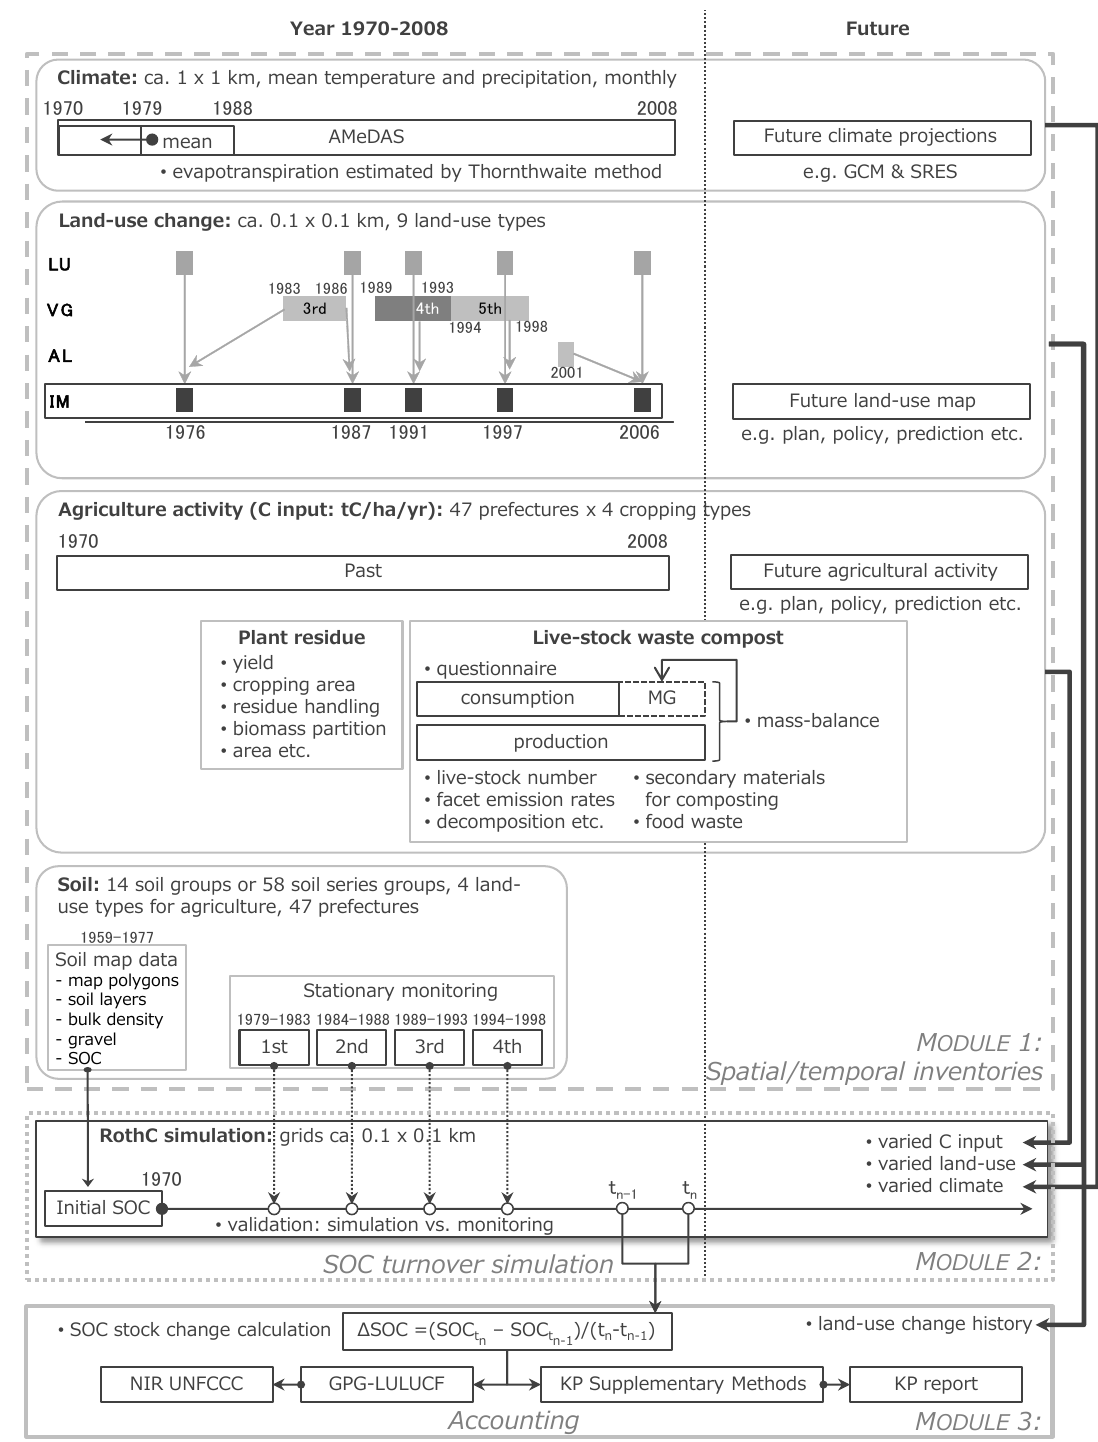
Figure 1. Schematic diagram of the system developed to simulate soil carbon stock change at country-scale using spatially explicit inventories on land-use change, climate, soil, and agricultural activity. The system is designed to be capable to simulate both historical and future soil organic carbon stock change, provided that spatial and temporal inventories are continuous or have appropriate time interval. See the text and Supplement for detail descriptions on other abbreviated text in figures; SOC: soil organic carbon: LU – land-use map, VG – vegetation map, AL – agricultural field map, IM – interpreted land-use/land-cover map, MG – managed grasslands, GCM – Global Climate Models, SRES – Special Report on Emission Scenarios of IPCC, KP – Kyoto Protocol, NIR – National Inventory